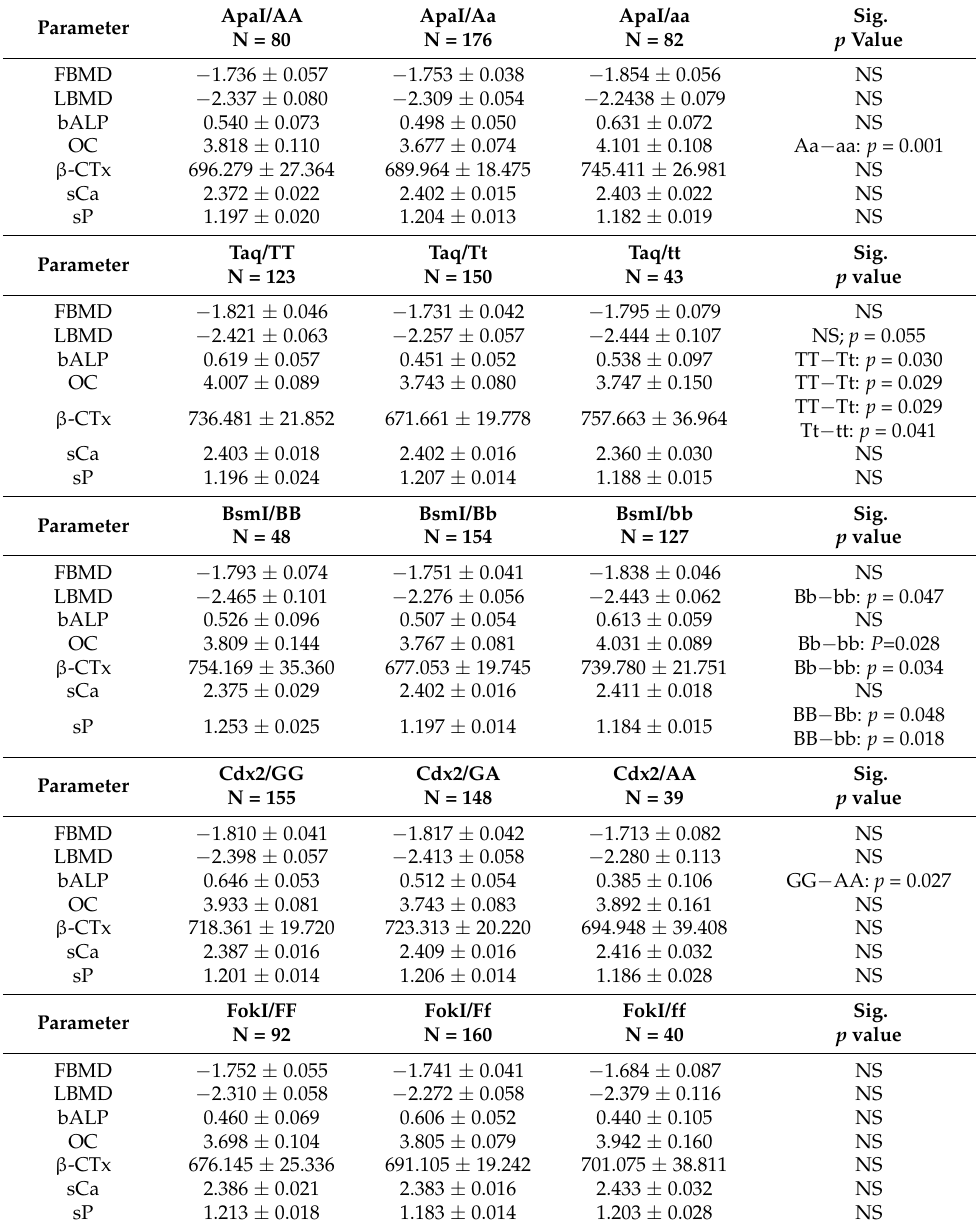
Table 4. Associations of the VDR gene polymorphisms with osteoporosis in postmenopausal